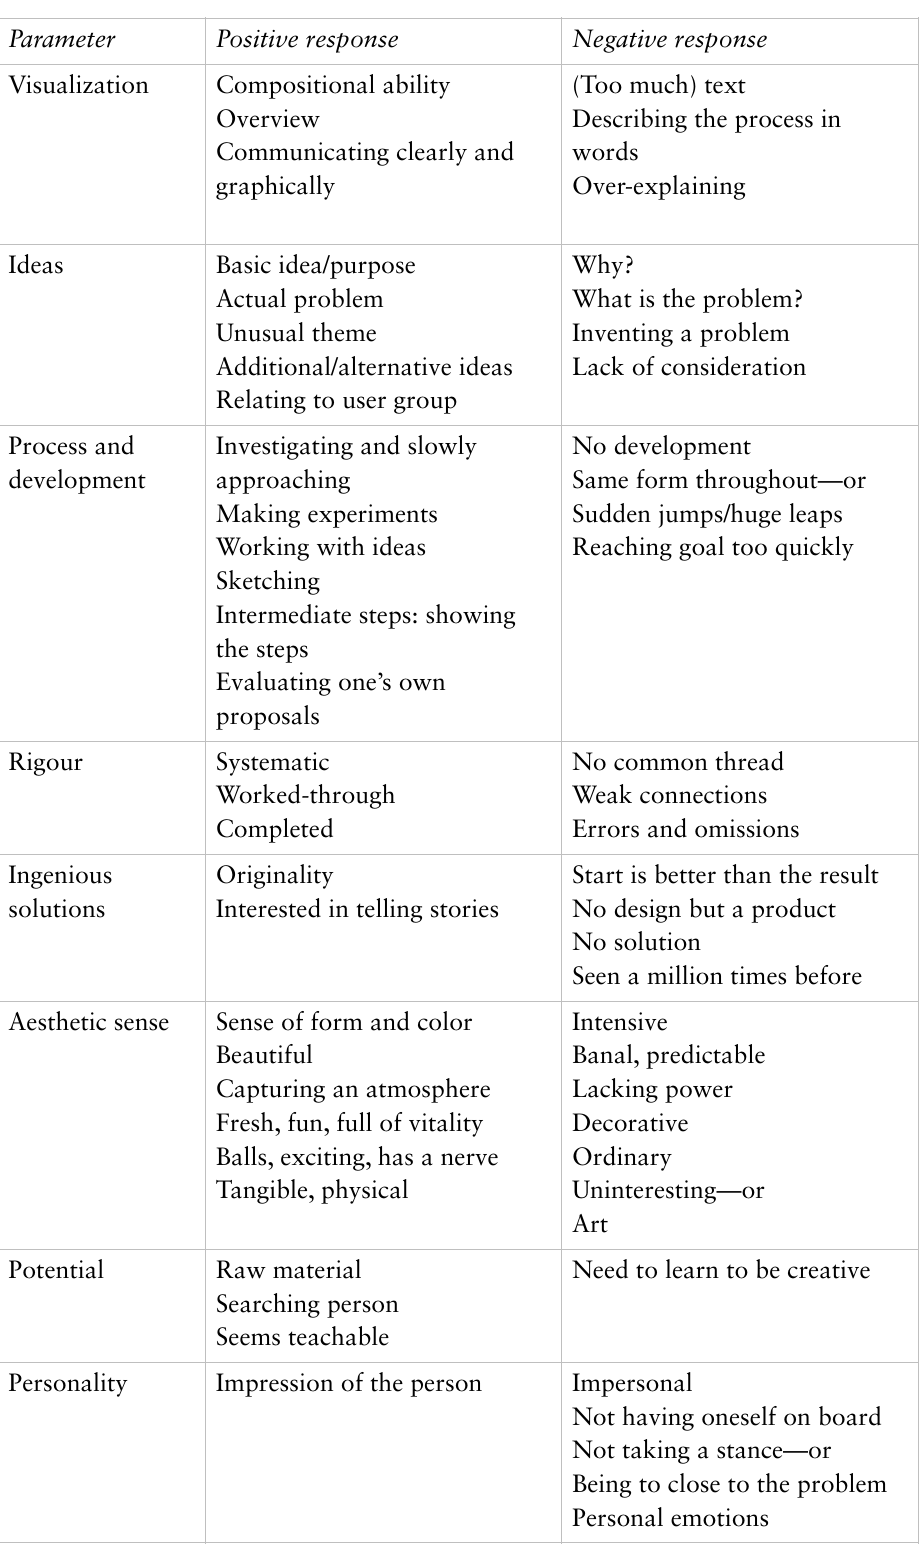
Table 4. Overview of evaluators’